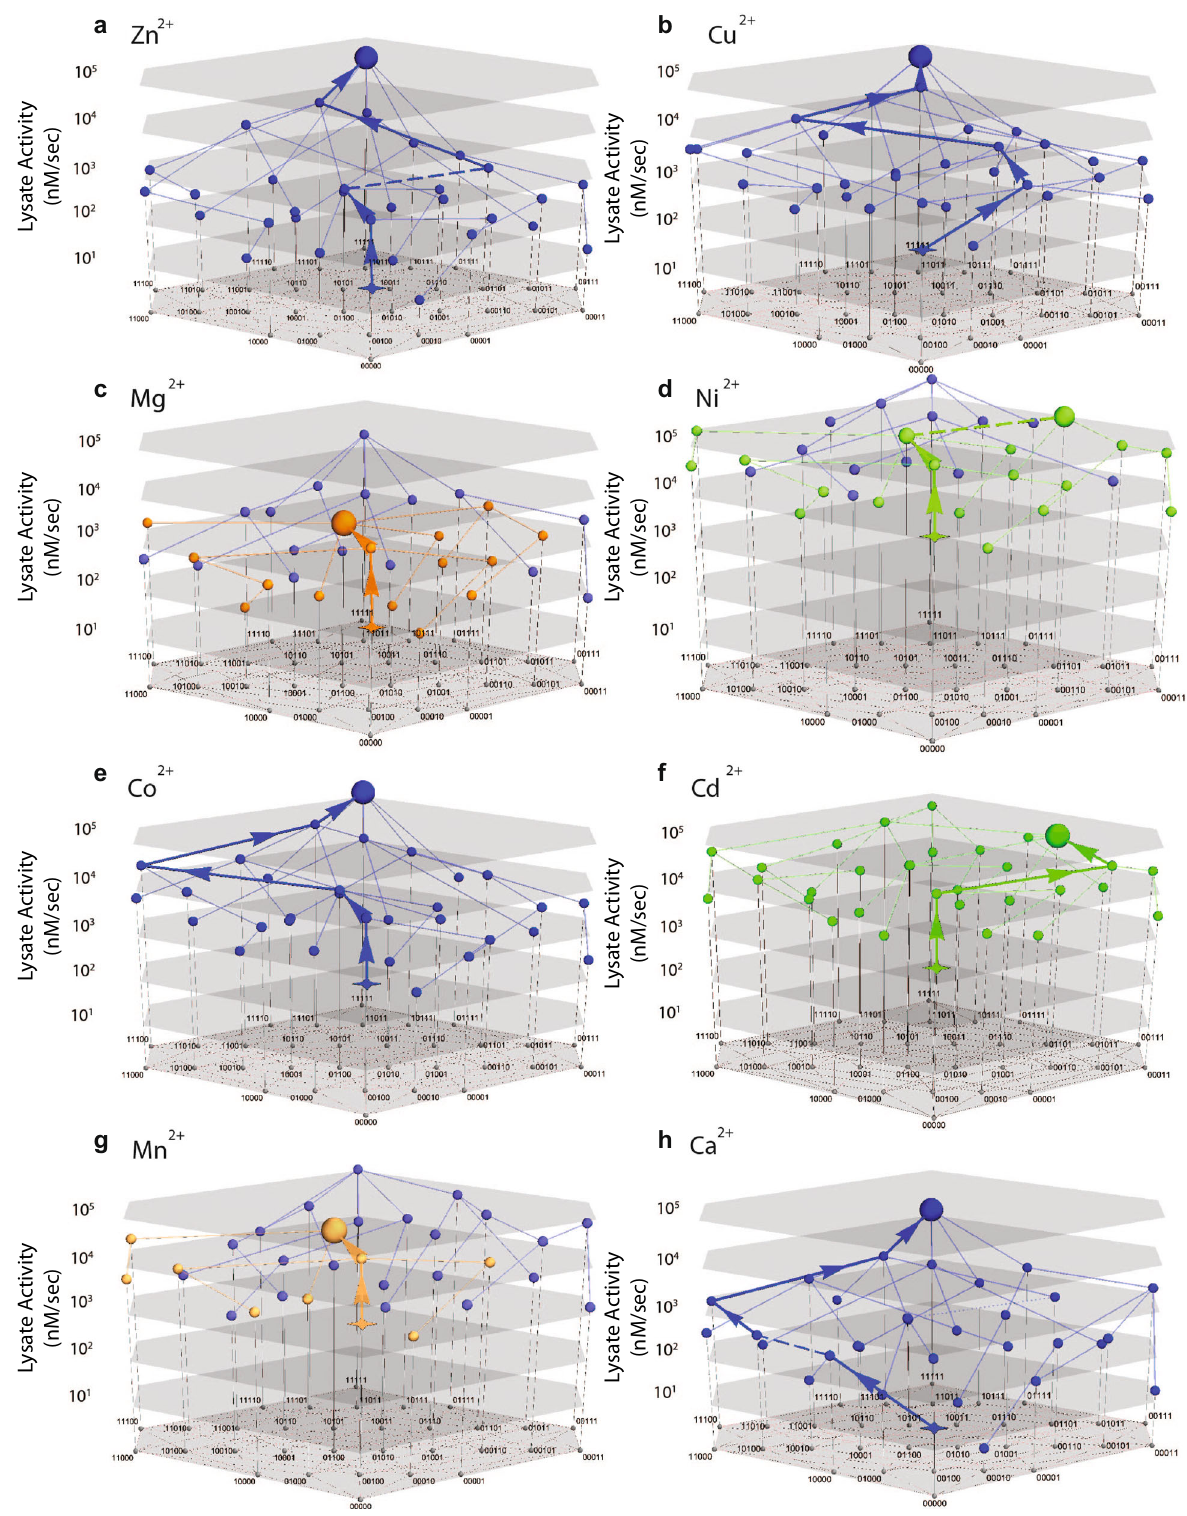
Fig. 3 Adaptive landscape and likely historical evolutionary trajectories for alternative metal environments. a – h The adaptive landscape encompassing all 32 genotypes that de fi ne this evolutionary transition for all metal environments tested. Local and global optimal genotypes are highlighted with larger nodes while the ancestral genotype (DHCH) is highlighted by a star node. Dashed lines or arrows indicate transitions that are within the margin of error. Blue nodes and lines indicate those that reach the derived genotype (11111); red nodes and lines indicate those that reach the second most common optimal genotype (01100); green nodes and lines indicate those that reach the third most common optimal genotype